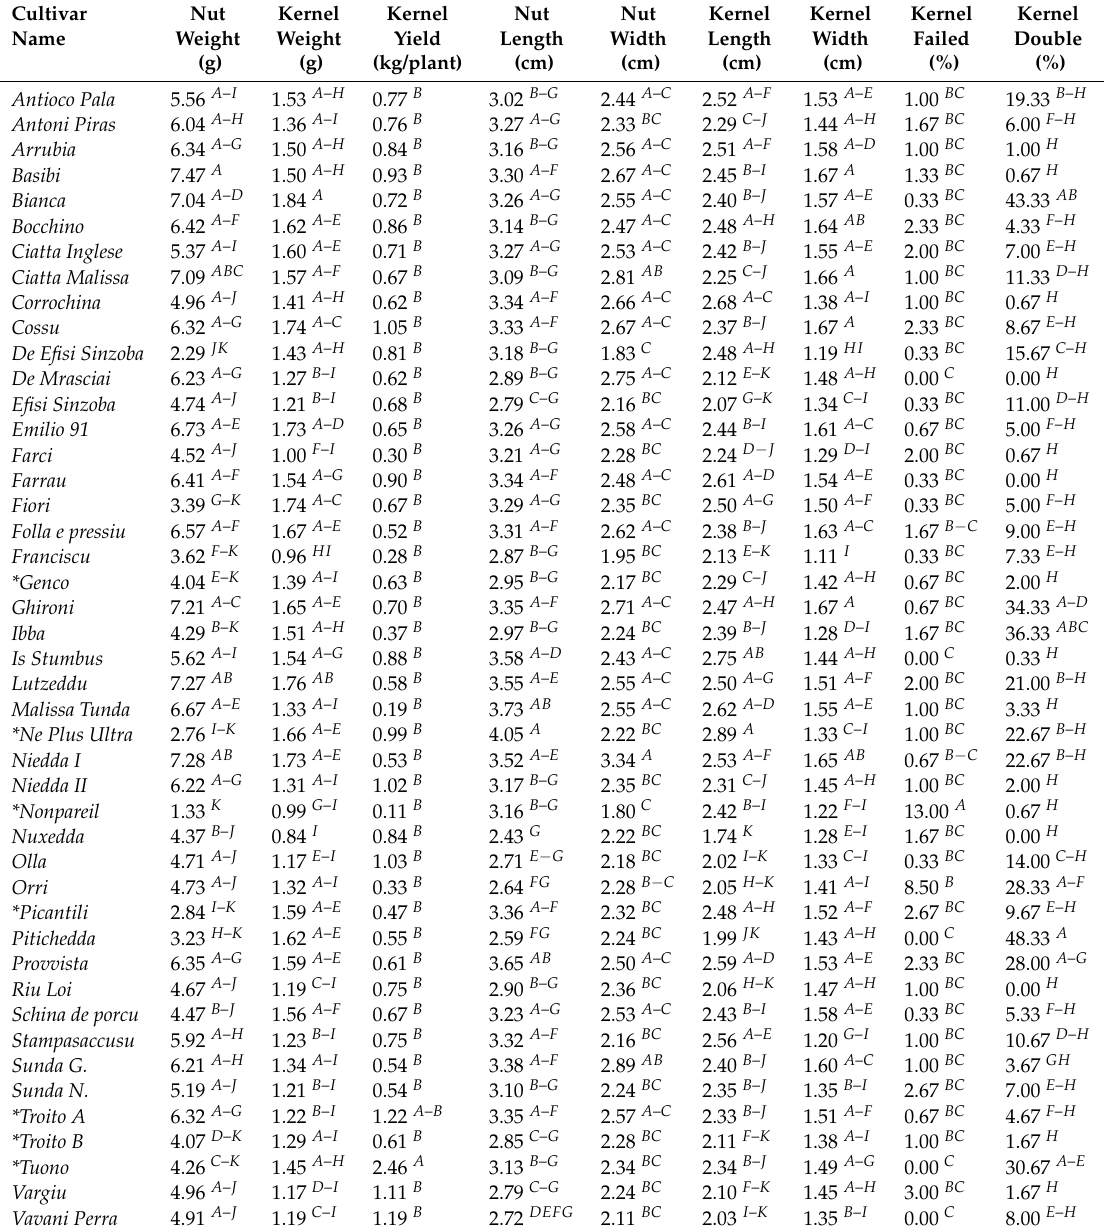
Table 3. Phenotypic traits of the almond cultivars. The names of the reference cultivars are preceded by an asterisk. (The capital letters represent Tukey–Kramer groups at p < 0.05. Cultivars sharing at least one TK symbol are not significantly different for the trait in the